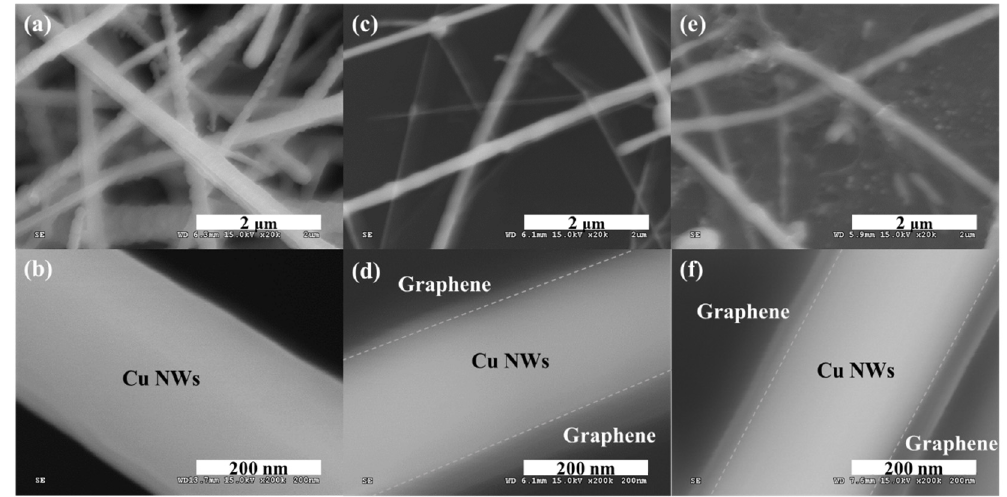
Figure 2. SEM images of ( a , b ): As-grown Cu NWs, ( c , d ): NG/Cu NWs;M20, and ( e , f ): NG/Cu NWs;M50.